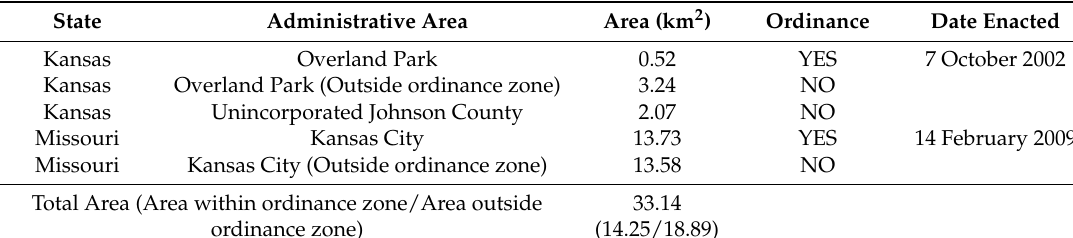
Figure 1. Kansas City Metropolitan Area USA and Blue River Basin. Table 1. Area distribution of the jurisdictional boundaries within the study area and the current status of streamside ordinances.